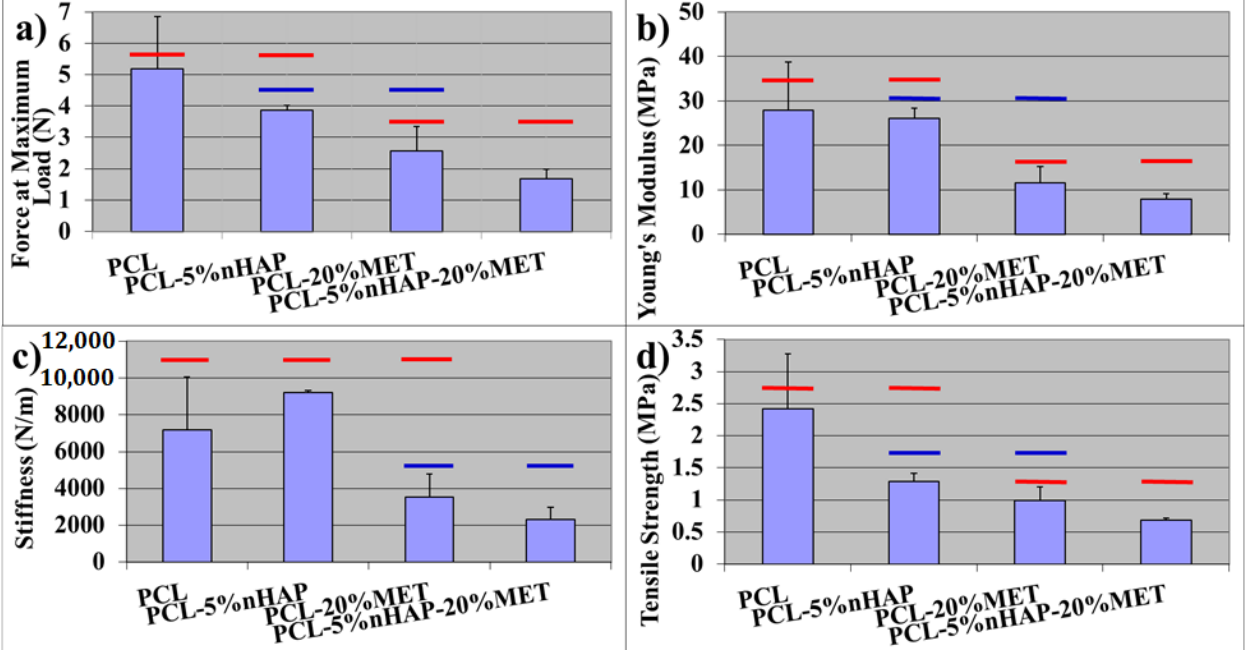
Figure 7. Mechanical properties of EMs: ( a ) force at maximum load (N) of EMs, ( b ) Young’s modulus (MPa) of EMs, ( c ) stiffness (N/m) of EMs and ( d ) tensile strength (MPa) of EMs. Red and blue horizontal bars indicate the mean values not statistically significantly different from each other, compared using Tukey ’s test ( p > 0.05).